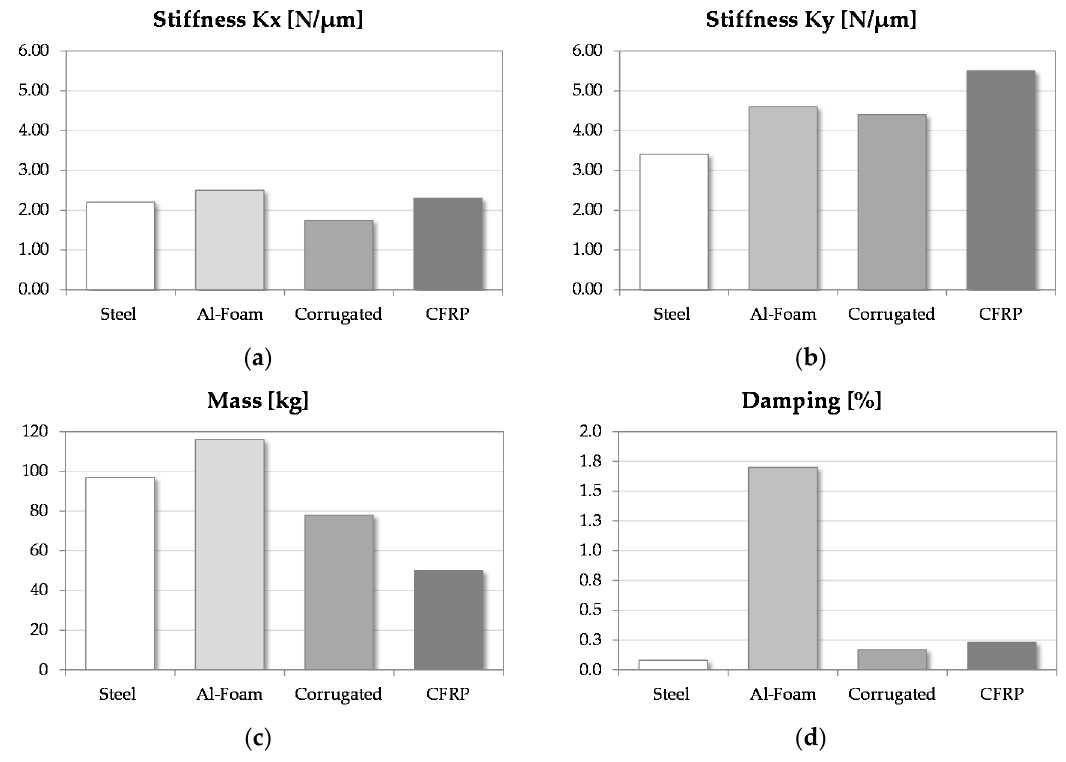
Figure 8. The result comparison: X -axis stiffness ( a ); Y -axis stiffness ( b ); mass ( c ); and damping ( d ).